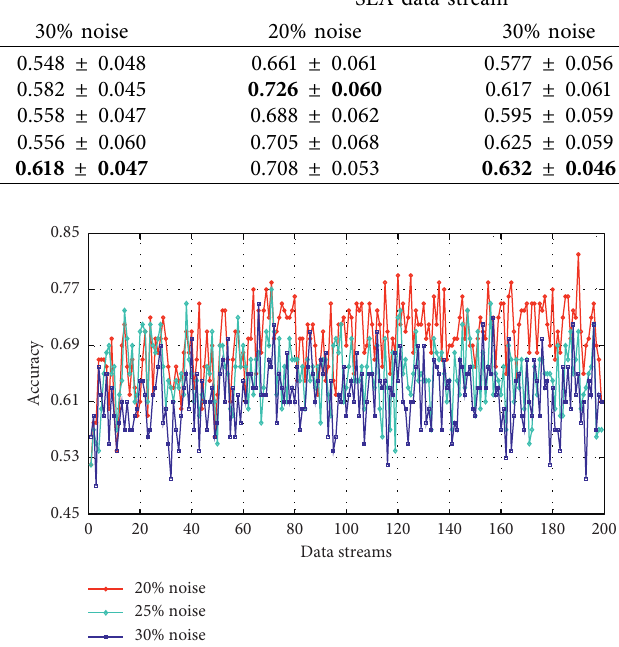
Figure 5: The accuracy curve for the MCBIE method with Hy- perplane data